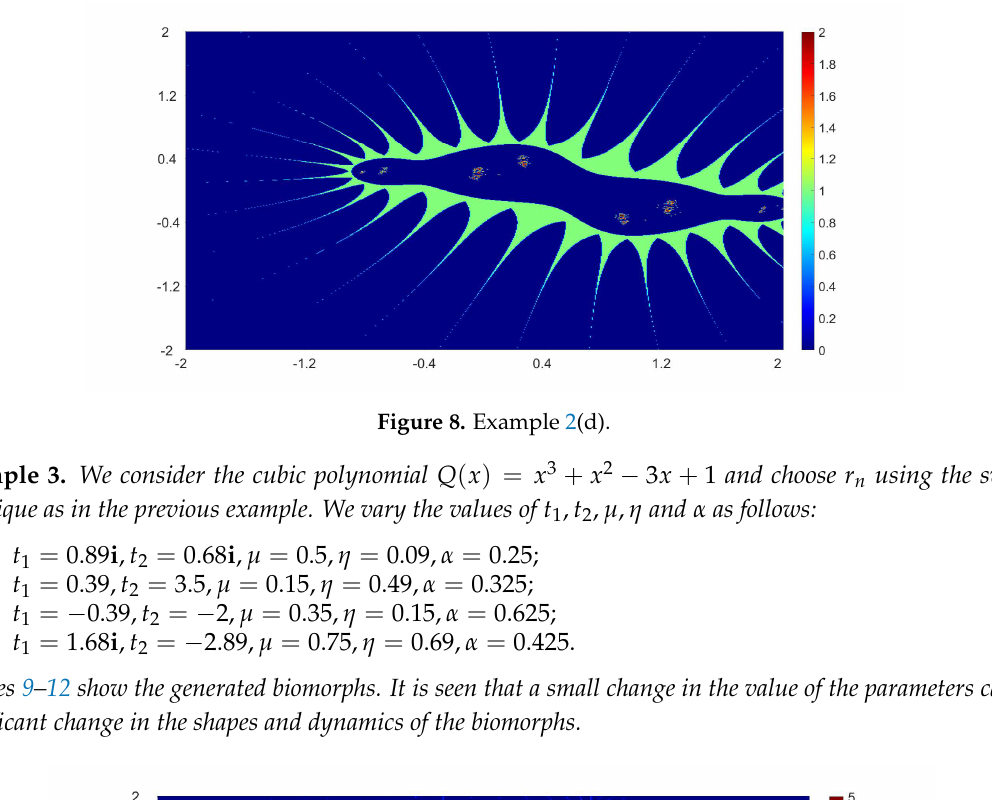
Figure 9. Example 3(a).